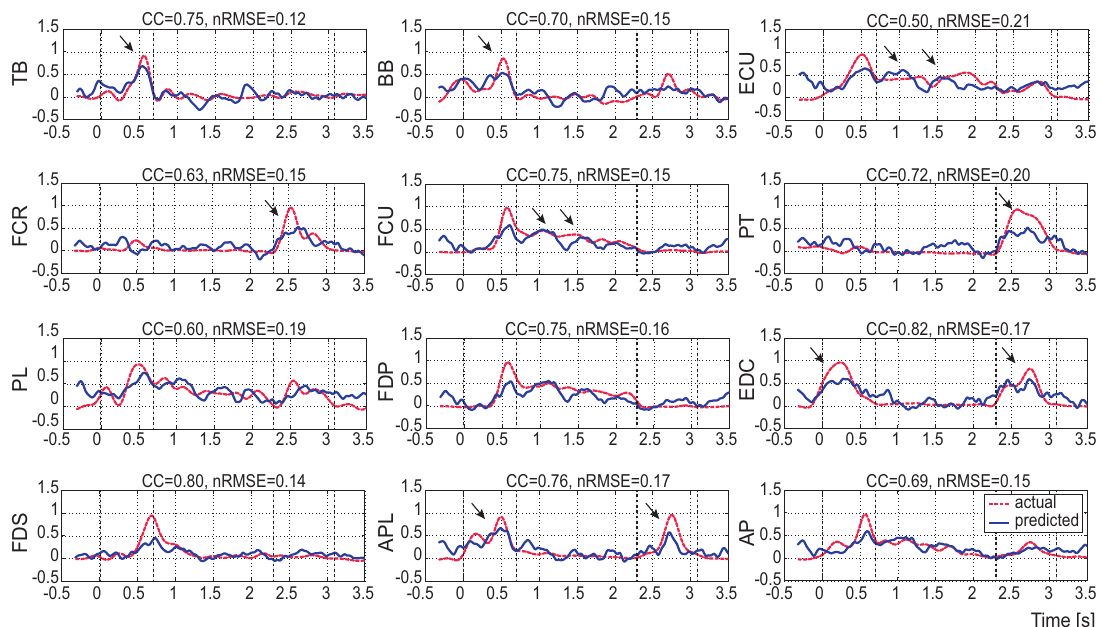
Figure 3. Representative example of predicted and recorded muscle activities. Dotted lines are actual muscle activities from EMG signals measured with wire electrodes, and solid lines represent predicted muscle activities from ECoG signals of monkey A. The normalized root mean square error ( nRMSE ) and correlation coefficient (CC) are also shown above each panel.